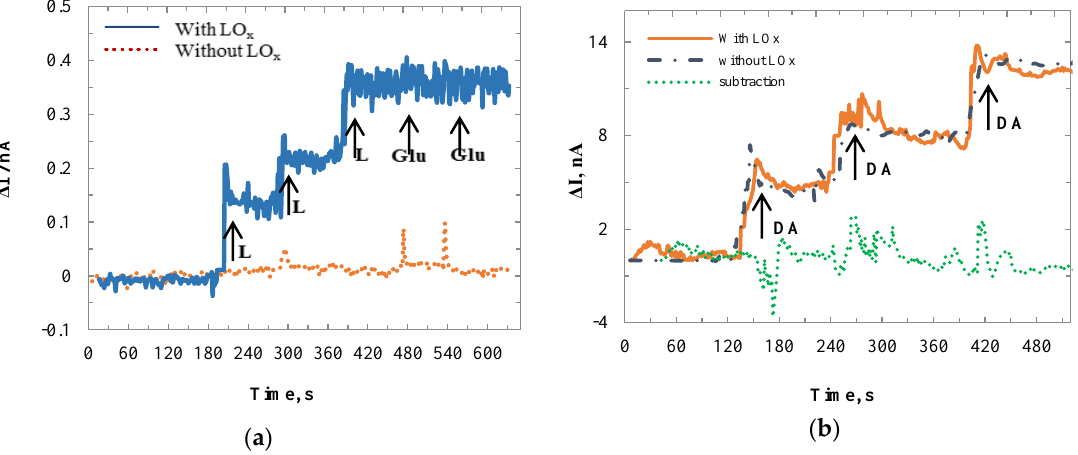
Figure 9. Time-current plots for WE (with LO x ) and SE (without LO x ) in 1× PBS with responses to ( a ) lactate and glutamate; and ( b ) dopamine only.